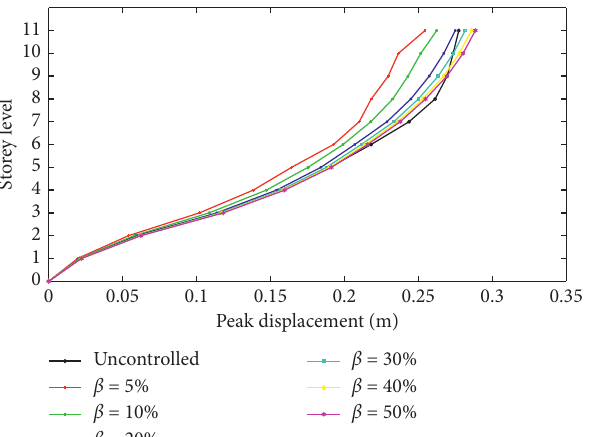
Figure 9: Peak displacement of each storey of the controlled structure subjected to “ Christchurch ” acceleration record for TMDI designed with µ � 5% and the J P optimization alternative.